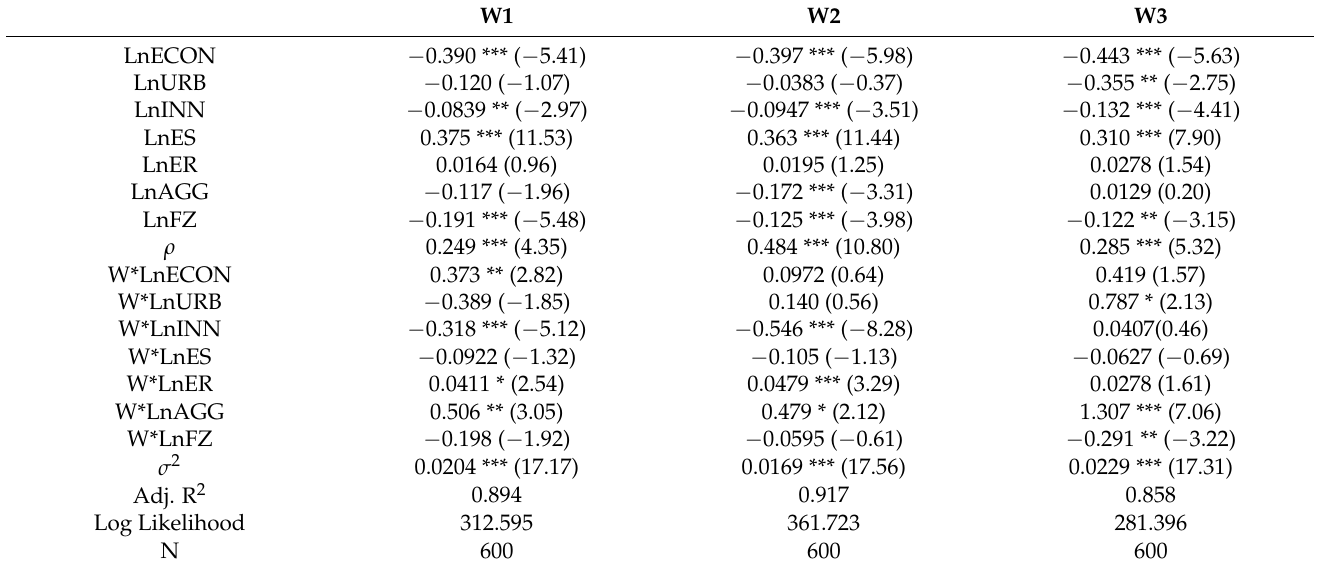
Table 5. Estimation results of SDM model under three spatial matrix